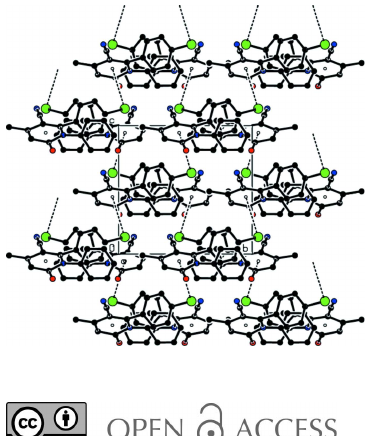
Figure 1 The reaction of acetoacetanilide with